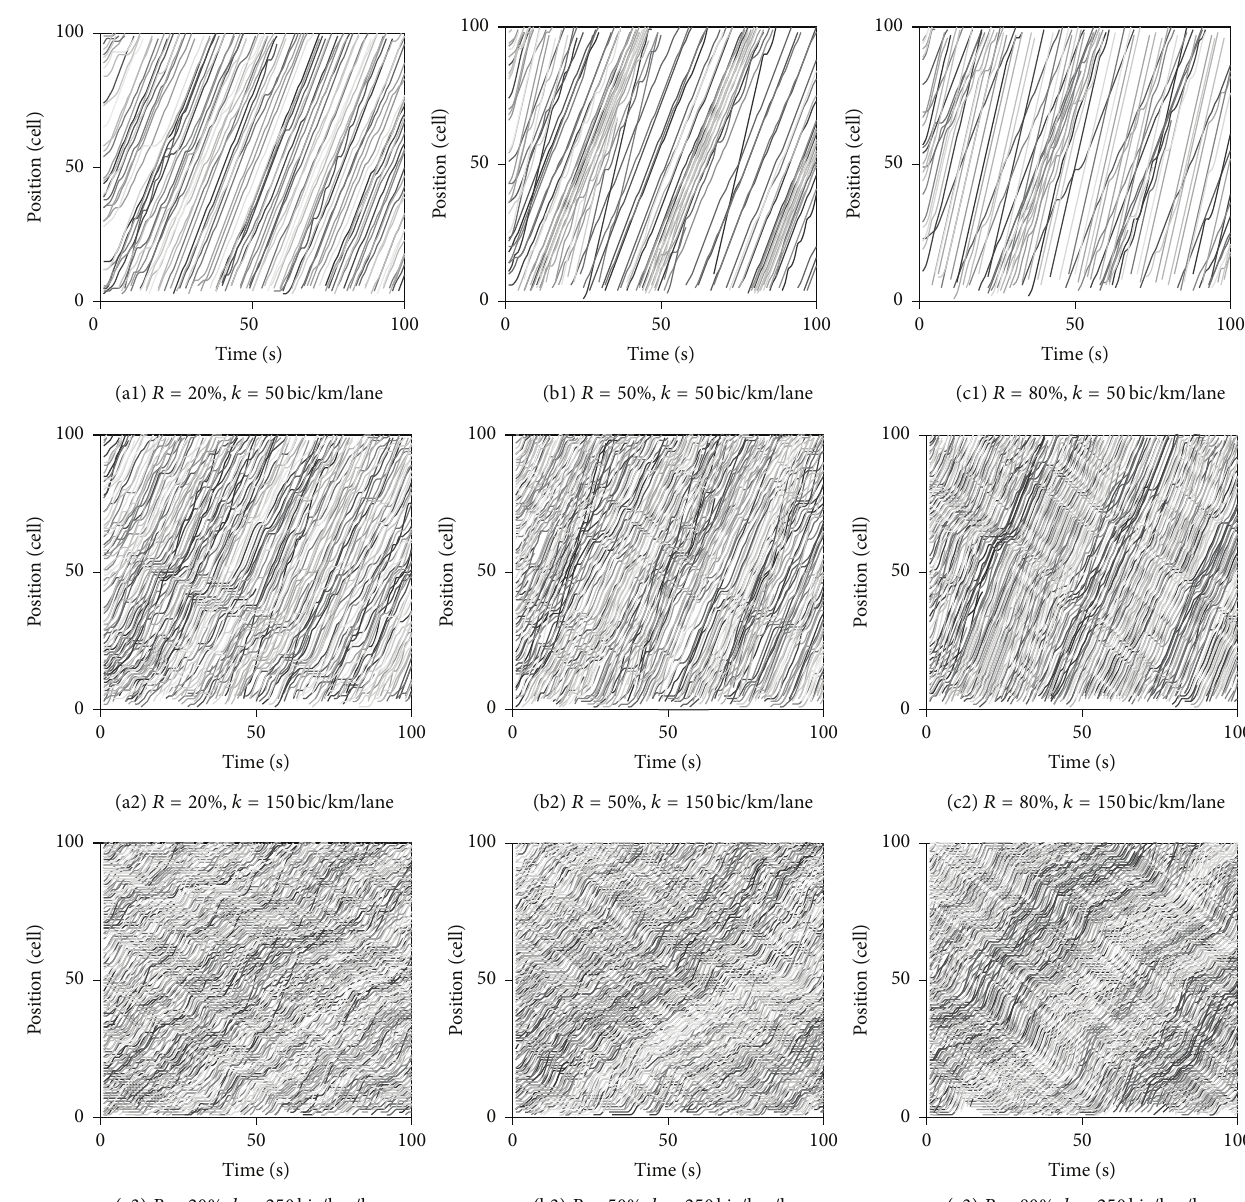
Figure 9: Traffic conditions with different proportions of